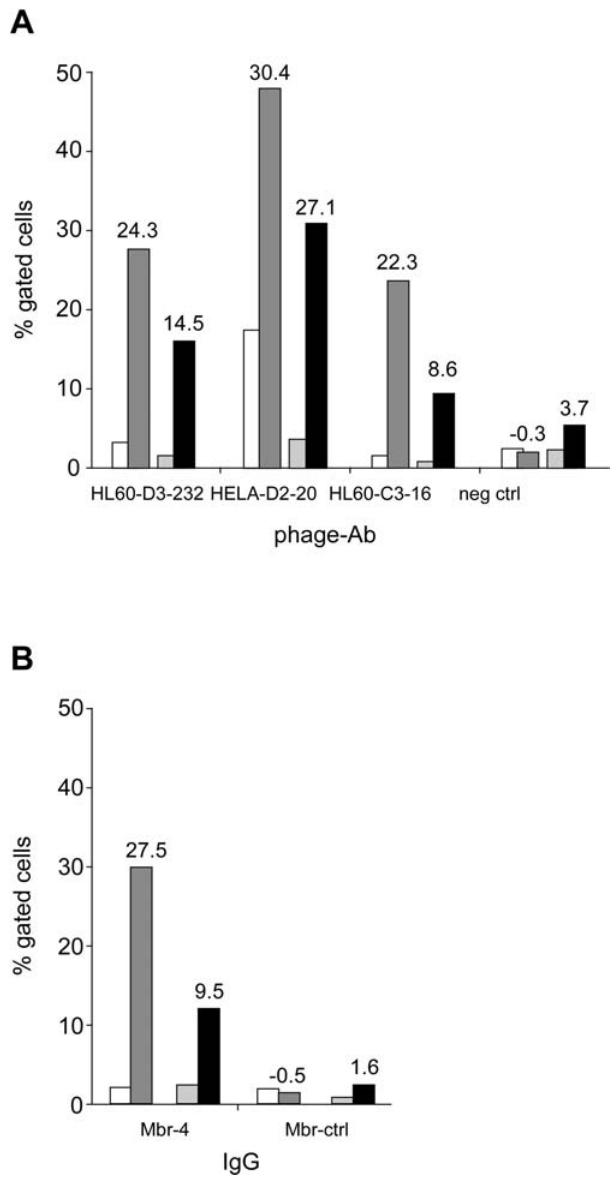
Figure 3. Binding specificity of selected clones. Binding of phage-Ab HL60-D3-232, HeLa-D2-20, HL60-C3-16 and a control phage-Ab (a) or of Mbr-4 and a control isotypic IgG (Mbr-ctrl; b) to human epithelial primary cells was measured by flow cytometry. Primary cells were obtained from matched tumor and adjacent normal tissue from CRC patients # 78 (white and dark grey bars, respectively) and # 80 (pale grey and black bars, respectively). Data are reported as percentage of gated cells. In panel a, numbers on top of tumor sample bars refer to the difference of percentage between that tumor and the matched normal sample (top line) and to the T/N ratio detected by tagArray analysis for the corresponding tags (bottom line). doi:10.1371/journal.pone.0001508.g003 conservative figure combining both approaches could be anything between 10 and 20 clones per target. It is worth noting that the 18 target receptors identified so far are membrane proteins with one or two trans-membrane domains and large ( . 700aa) extra-cellular domains, along with several GPI-anchored membrane proteins.